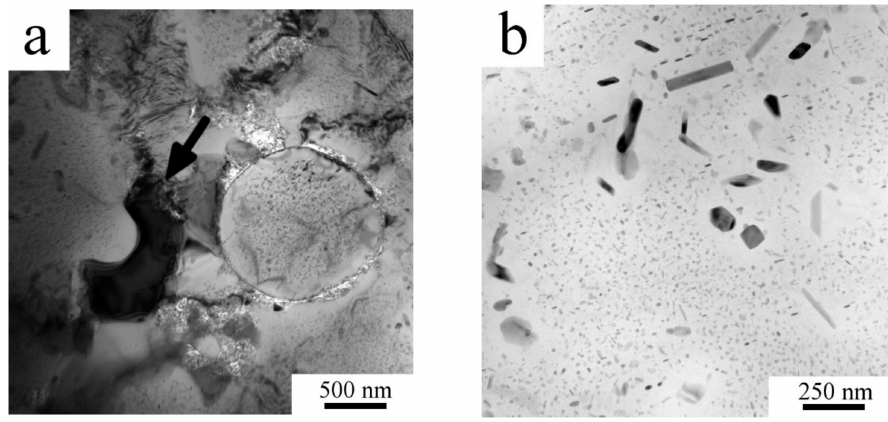
Figure 10. The microstructure of the Al7075_AC compact ( a ) and its detail ( b ), TEM. Due to the much finer microstructure of the Al7075_MC compact, its microstructural details were particles located predominantly at triple points or along grain boundaries. The typical size of these precipitates is below 500 nm. Simultaneously, much smaller precipitates (spherical or elongated) of